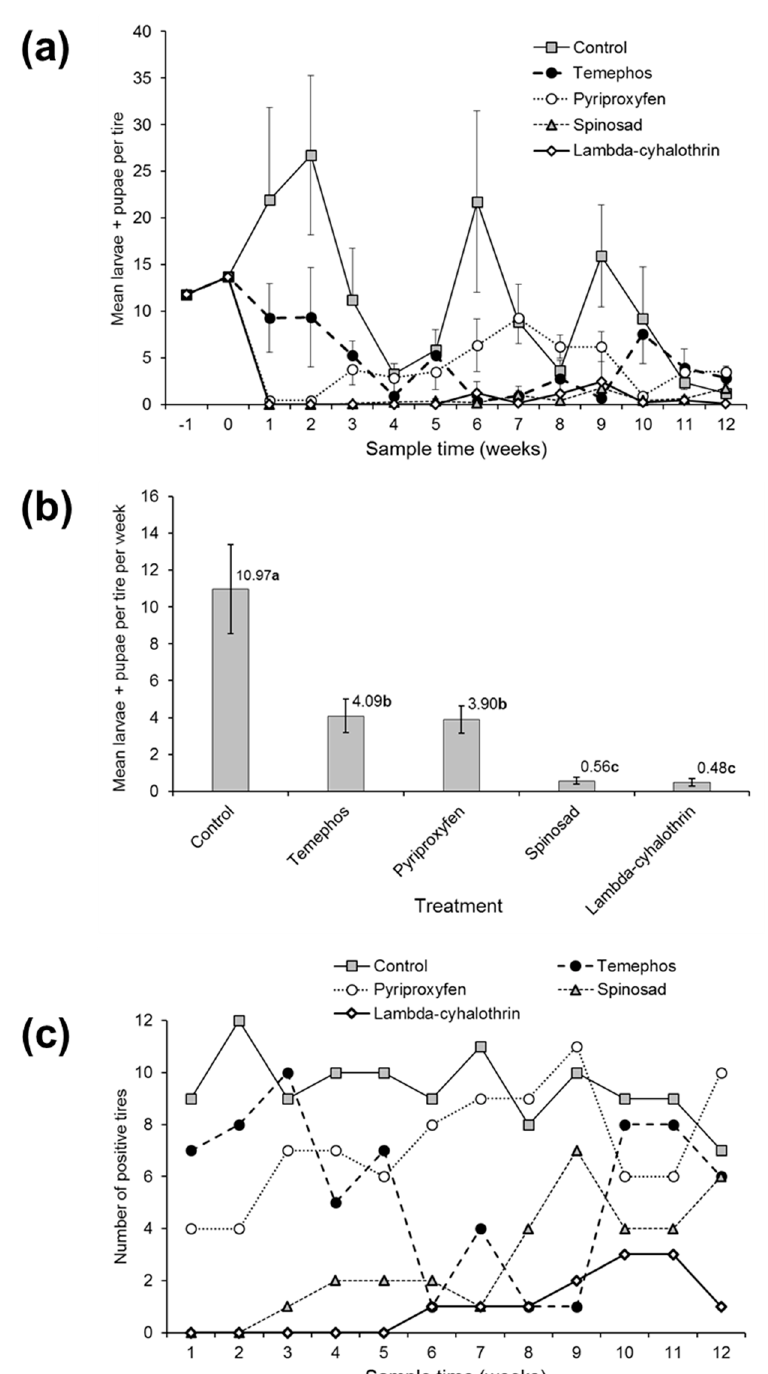
Figure 1. The efficacy of larvicides applied to used vehicle tires in terms of ( a ) the mean weekly counts of Aedes spp. larvae + pupae involving two pre-treatment samples and 12 weeks of post-treatment samples. ( b ) The overall mean numbers of Aedes larvae + pupae during the post-treatment period. ( c ) The number of tires in each treatment that were positive for Aedes larvae and pupae at each sample time (N = 12 tires per treatment). The vertical bars indicate SE. The values above columns in ( b ) indicate the mean. Values followed by identical letters did not differ significantly (Tukey, p > 0.05).